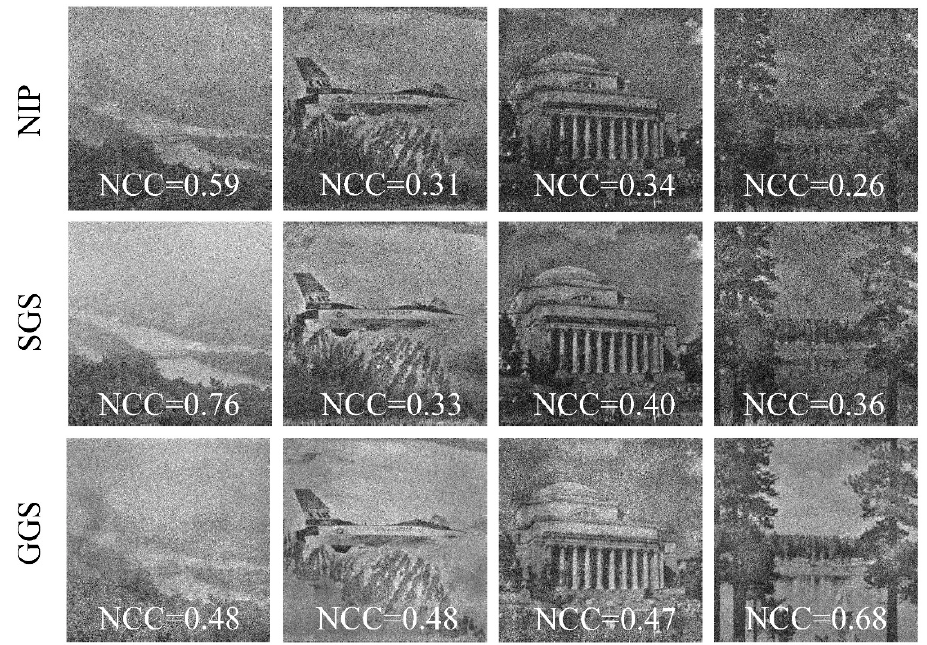
Figure 11. The reconstruction holograms of three modified GS algorithm.